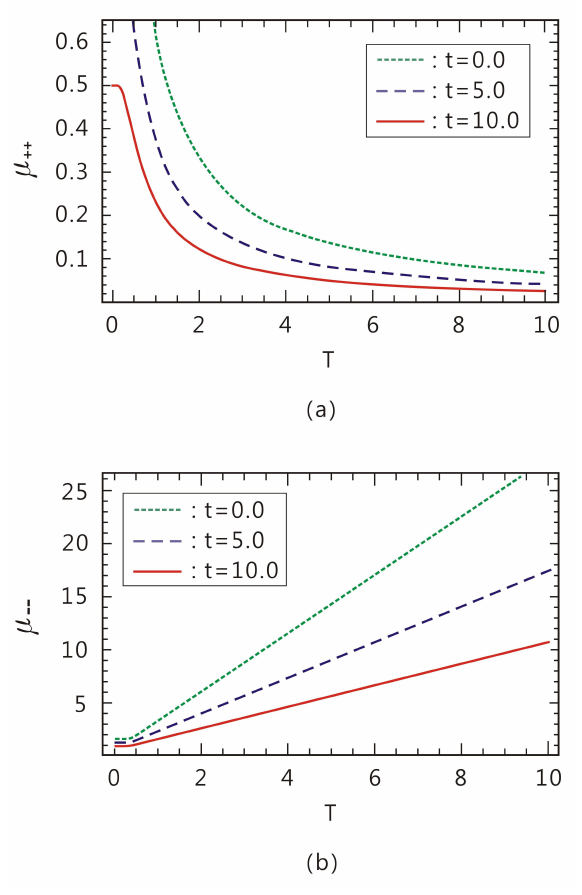
Figure 1: Temperature dependence of µ ++ (a) and µ −− (b) for three different values of t . We used (cid:126) = 1 , ω = 1 , σ = 0 . 1 , (cid:15) = 1 , and k = 1 .